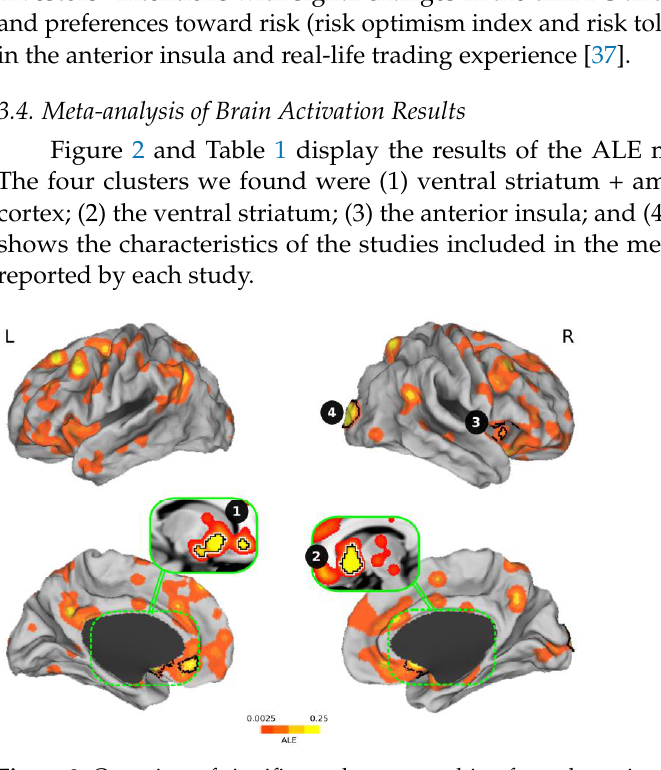
Figure 2. Overview of significant clusters resulting from the activation likelihood estimation (ALE) meta-analysis regarding investment decision-making. The four clusters found during risky and safe investments were (1) ventral striatum + amygdala + anterior cingulate cortex; (2) the ventral striatum; (3) the anterior insula; and (4) the occipital cortex. The clusters corrected for multiple comparisons are outlined in black. L = left, R = right. Table 1. Significant clusters of the meta-analysis surviving to multiple